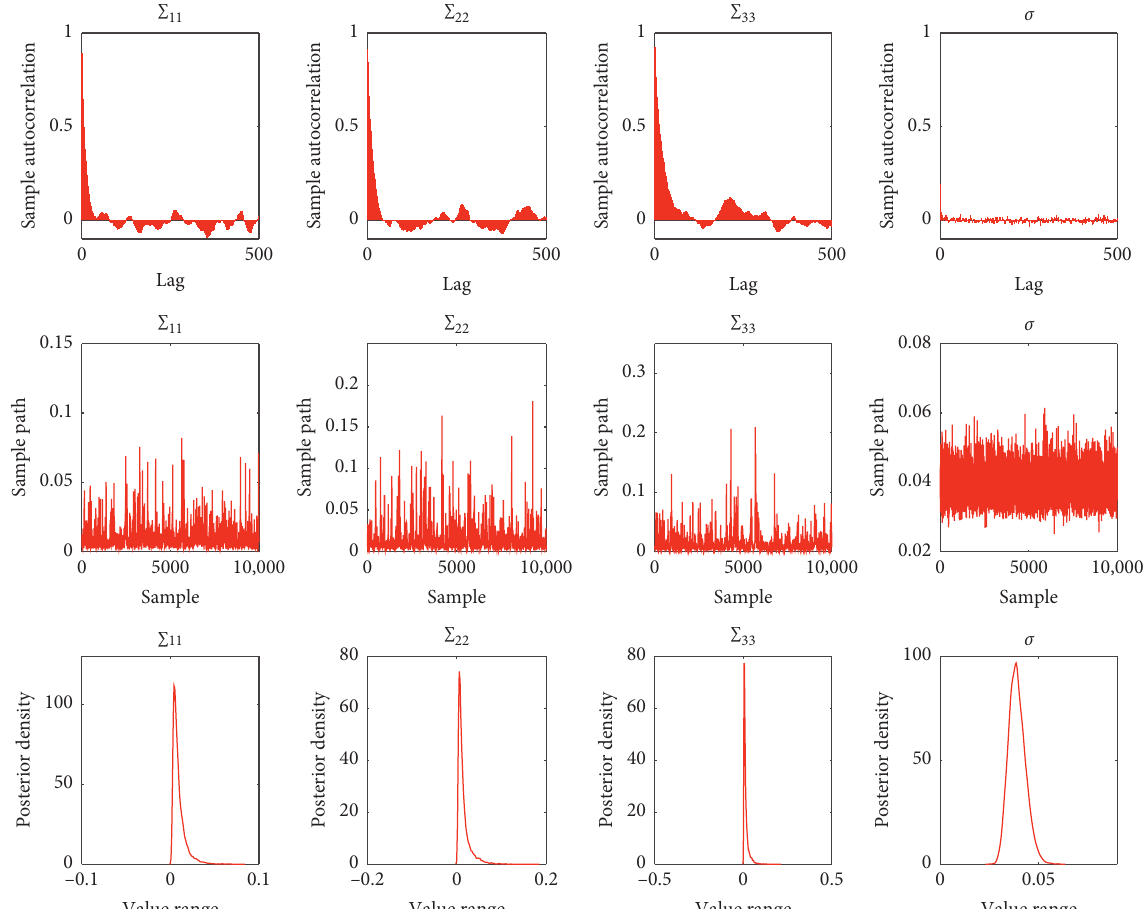
Figure 4: Sample autocorrelation function, sample path, and posterior density of TVP model